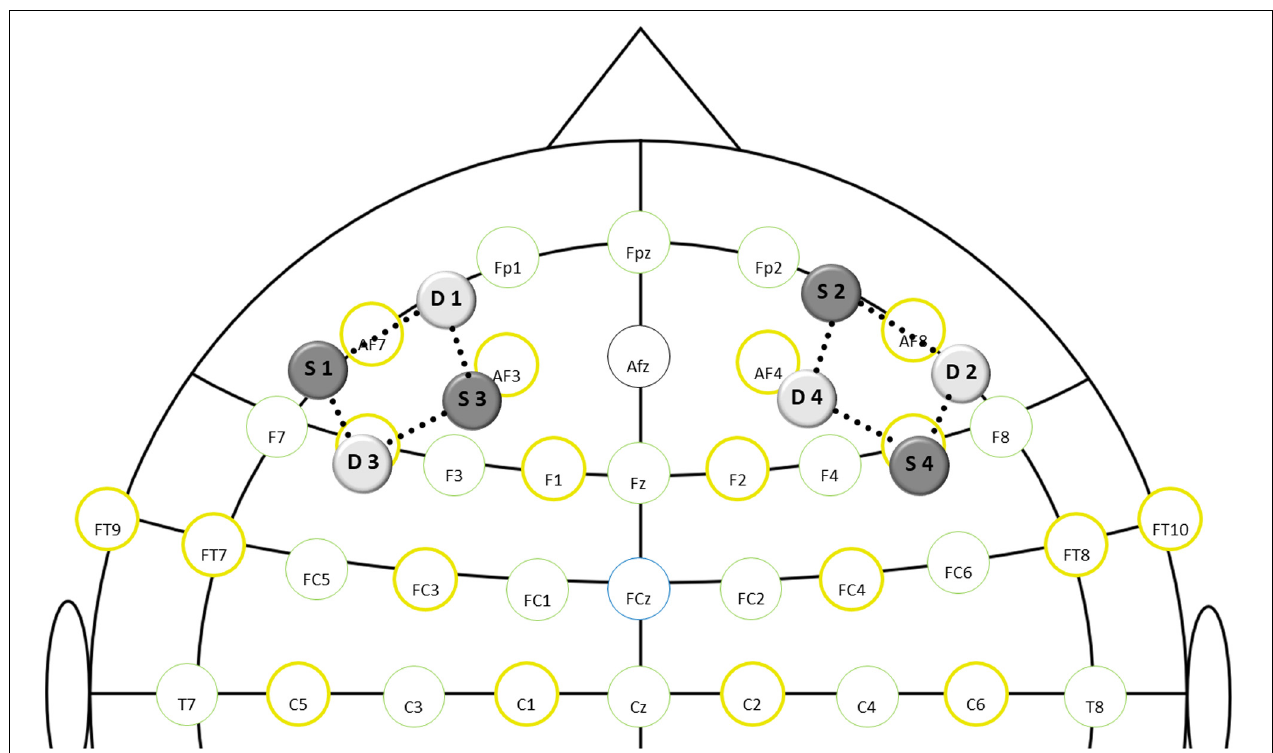
FIGURE 2 | fNIRS montage layout in relation to standard EEG positions (S-source; D-detector; dotted lines-channels).